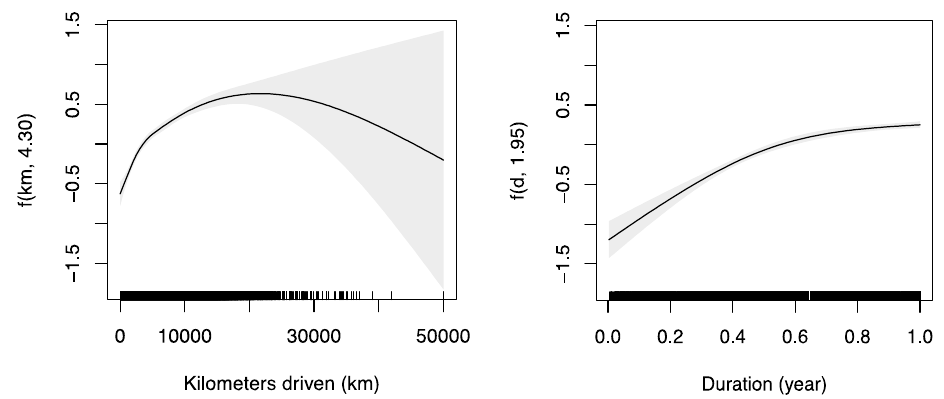
)(ˆ kmf on the left and )(ˆ df on the right for claims not at fault with Figure 5. Model 1, ˆ f 1 ( km ) on the left and ˆ f 2 ( d ) on the right for claims not at fault with property Figure 5. Model 1, 1 2 damage ( nb property damage ( nb 2).